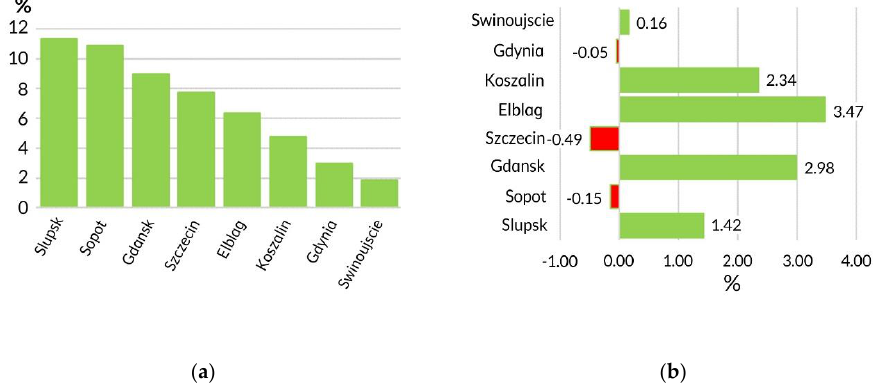
Figure 14. The urban green ratio in the city counties: ( a ) UGrR in 2018; ( b ) UGrR changes in 1990-